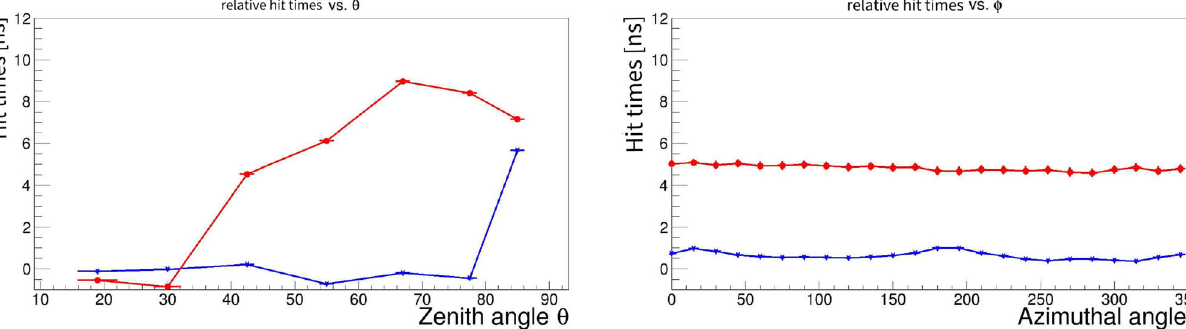
Fig. 42 Uniformity of relative TT (normalized to the LED_0 angle_0 of each scanned PMT itself) along the zenith angle ( θ , left) and azimuthal angle ( φ , right) on average of all measurements with the same zenith angle or azimuthal angle of all the scanned PMTs. Blue: HPK PMTs; red: NNVT PMTs